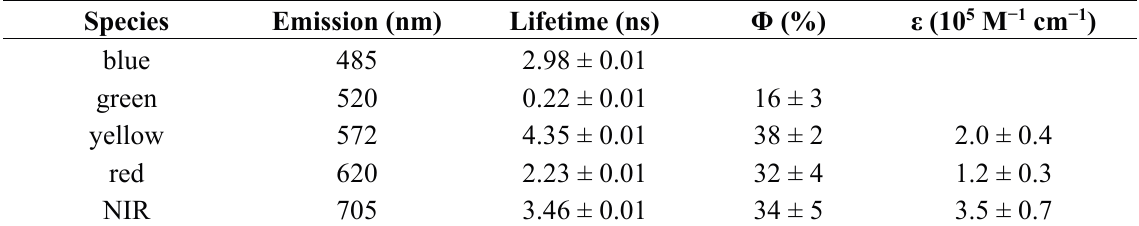
Table 3. Photophysical parameters of DNA-templated Ag nanoclusters [140]. Reprinted with permission from [140]. Copyright 2014 American Chemical